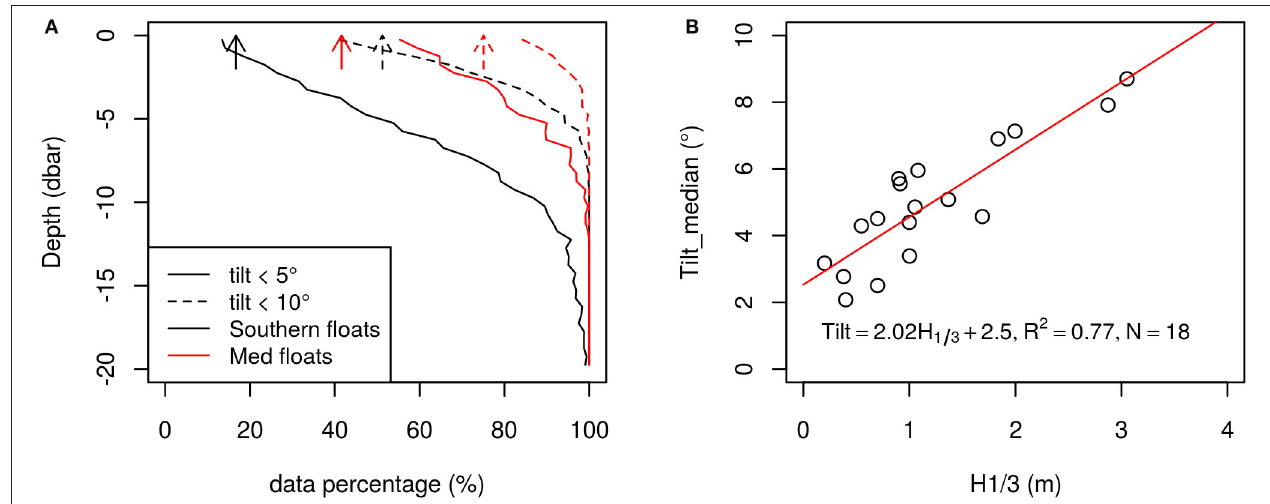
FIGURE 5 | (A) Percentage of the data point below 5 ◦ (solid lines) and 10 ◦ (dashed lines) as a function of depth for the Southern Ocean (black) and the Mediterranean Sea (red). Arrows represent values during “buoy” mode. (B) median of the tilt within the shallowest 5m as a function of waves height derived from a meteorological mooring (Mediterranean Sea only, float lovapm006d ).